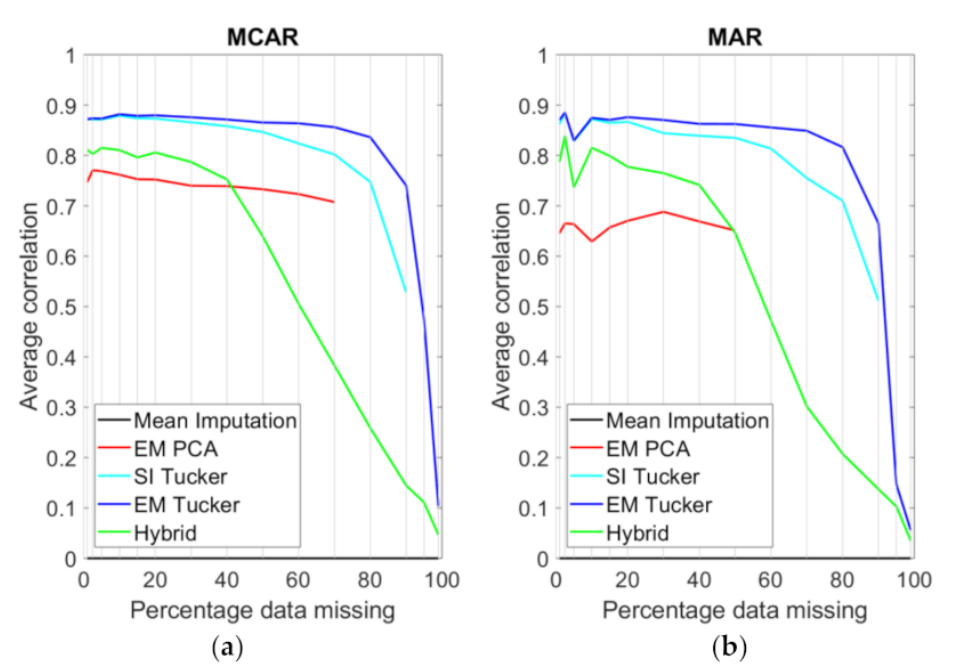
Figure 11. Average correlation between the ground truth and the gap-filled data for SPAIN1 based on each of the methods at different levels of artificially added missing data, both for MCAR ( a ) and MAR ( b ). The correlation for the mean imputation method was always zero for all levels of missing data (the black line).